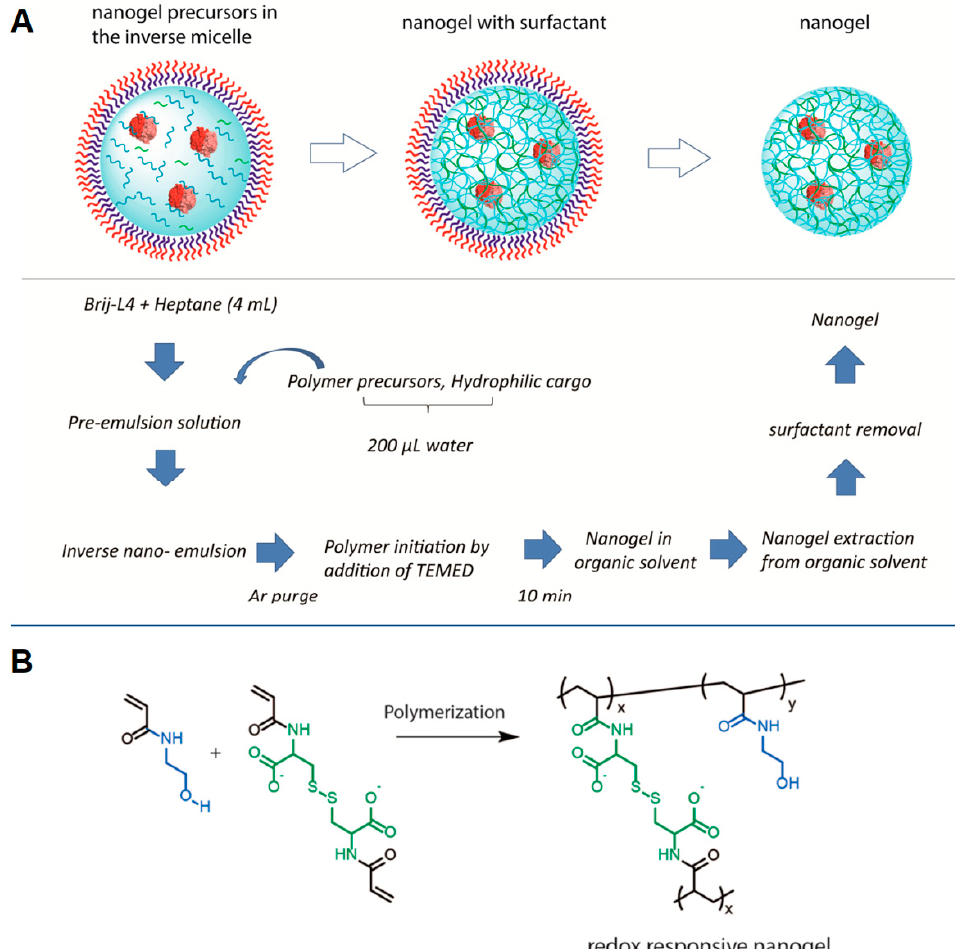
Figure 2. NG synthesis by inverse emulsification in the presence of Brij-L4 surfactant. ( A ) Protocol used in NG formation; ( B ) polymerization between hydroxylethylacrylamide and cystine diacrylamide giving rise to the nanonetwork. Reprinted with permission from Raghupathi et al. [22]. Copyright (2017) American Chemical Society.